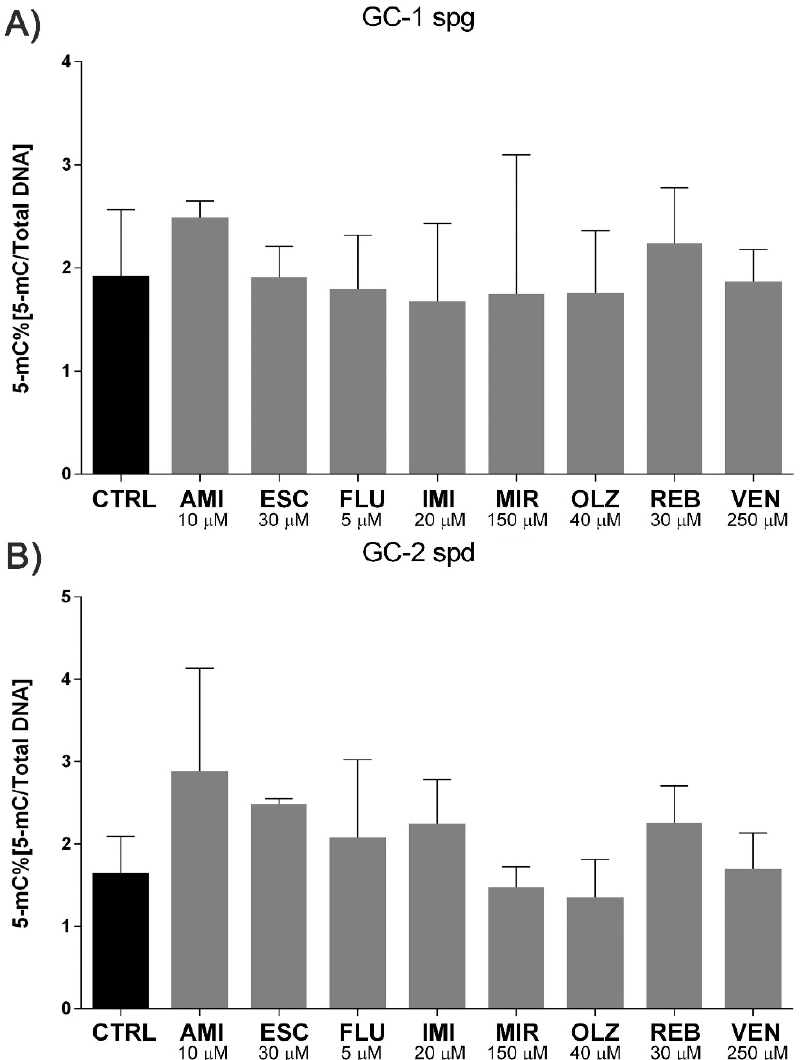
Figure 5. Antidepressants do not alter the methylation DNA amount. Mouse GC-1 spg and GC-2 spd cells were treated for 48 and 96 h and then the effects of antidepressants on global DNA methylation status were evaluated ( A , B ). Statistical differences were determined using one-way analysis of variance (ANOVA) with Dunnett’s post-hoc test; p values < 0.05 were considered statistically significant, no indication–no statistical significance.